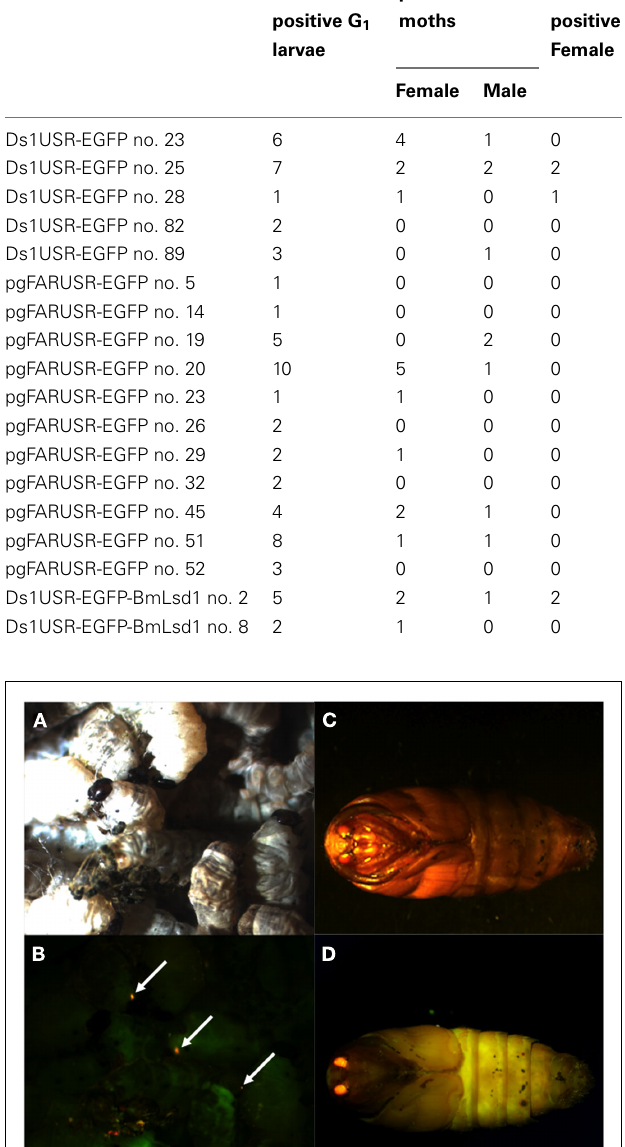
expression in various tissues at different developmental stages (e.g., embryo, larvae, pupae, adult) for DsRed-positive G 2 females (data not shown). This result indicates that the PG-specific gene promoter resides within the 3,844-bp DNA sequence correspond- ing to the upstream region of Bmpgdesat1. Of the 803 eggs injected with the pBac/3xP3-DsRed2/pgFARUSR-EGFP